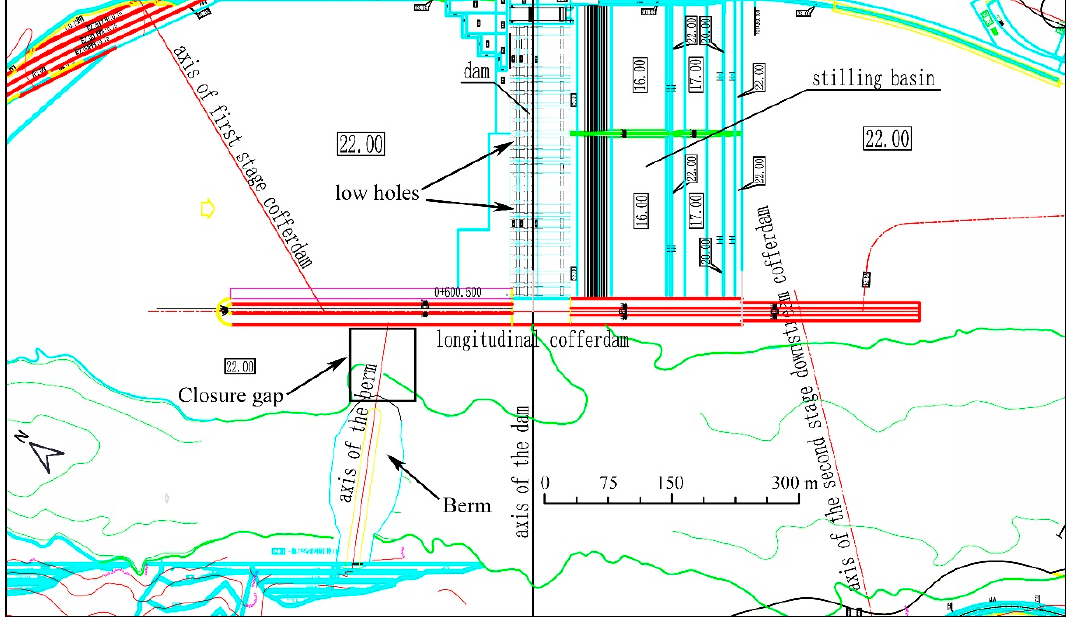
Figure 2. Local layout of physical experiment.